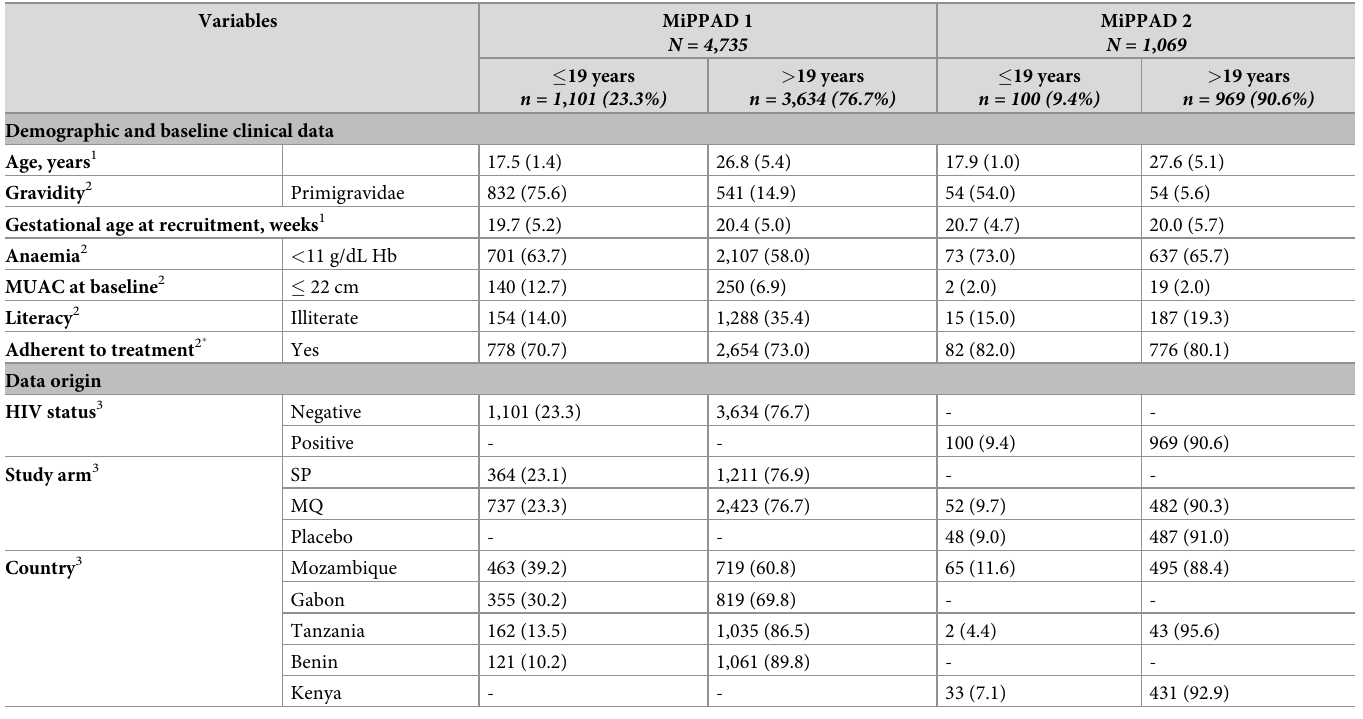
Table 2. Characteristics of study participants by trial and age group.